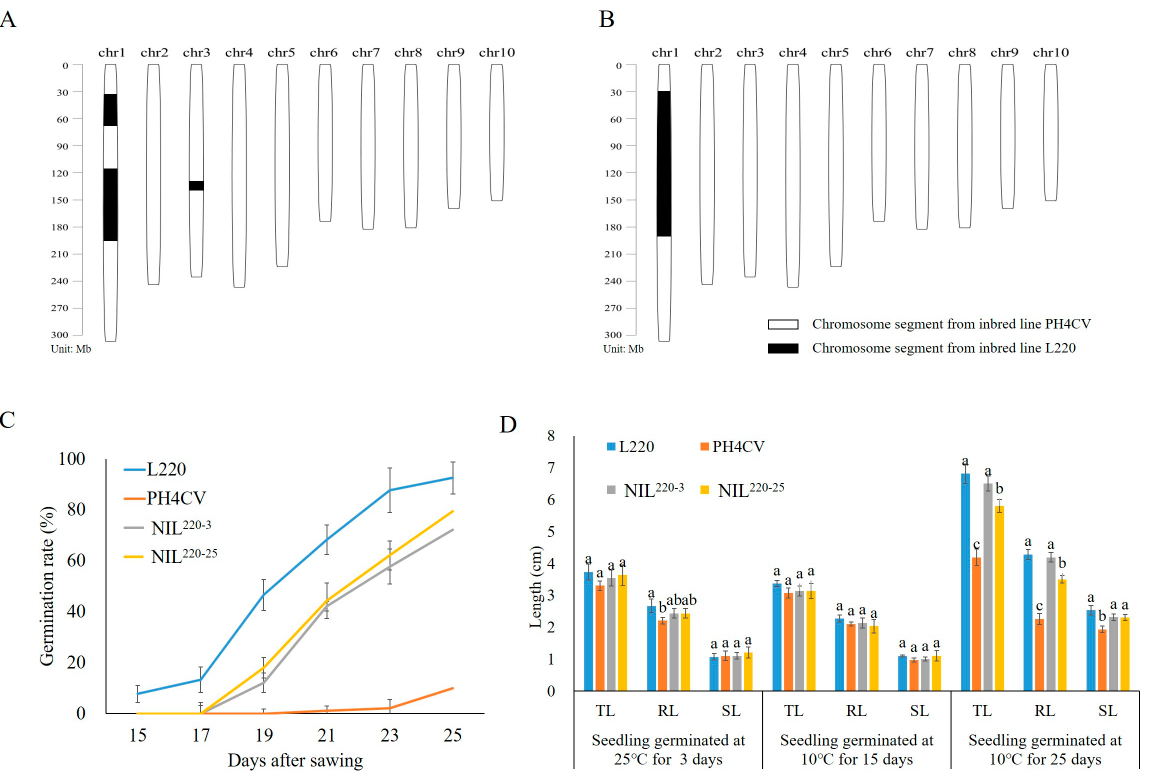
Figure 1. Characteristics of L220, PH4CV, and their near-isogenic lines NIL 220-3 and NIL 220-25 . ( A , B ) Genomic composition of NIL 220-3 ( A ) and NIL 220-25 ( B ). Blank represents regions homozygous with PH4CV, and black represents homozygous regions from L220. ( C ) Emergence rate of seed germinated at 10 ◦ C for 15–25 days. ( D ) Total length (TL), root length (RL), and shoot length (SL) of seedling germinated at 25 ◦ C for 3 days, and at 10 ◦ C for 15 and 25 days. Values represent mean ± SE ( n = 3). Different letters indicate significant difference at p ≤ 0.05 within a trait among different genotypes that germinated in the same